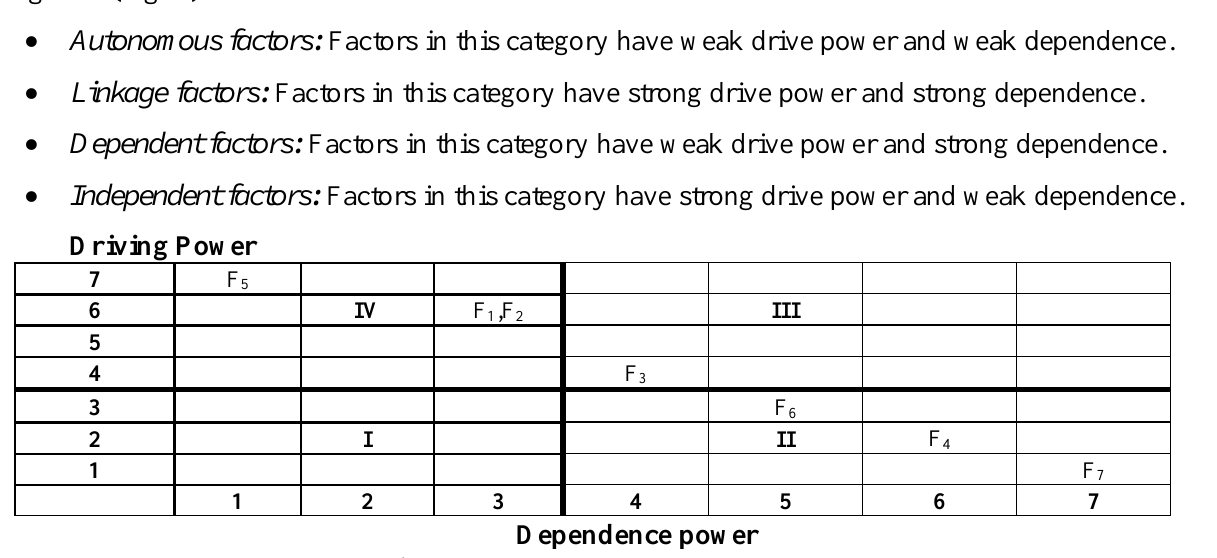
Fig. 5. Driving power-dependence